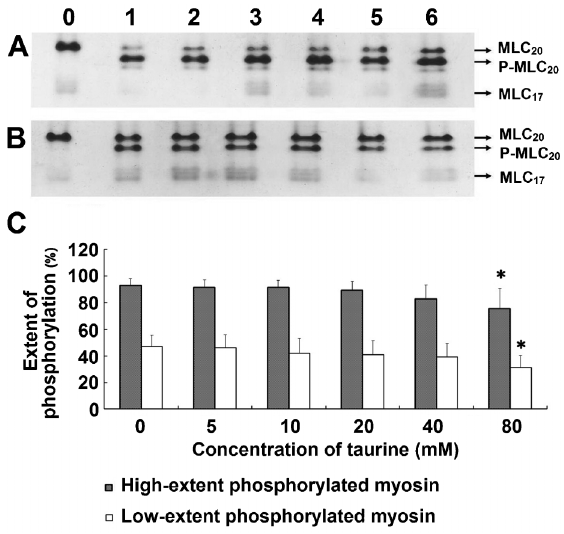
Figure 6. Effects of taurine on phosphorylated myosin. A , Effects of taurine on high-extent phosphorylated myosin, 0.02 m M myosin light chain kinase (MLCK), and 4.0 m M myosin purified from chicken gizzard smooth muscle used in the assay. B , Effects of taurine on low-extent phosphorylated myosin, 2.0 m M MLCK and 4.0 m M myosin purified from chicken gizzard smooth muscle used in the assay. Lanes 0-6 represent unphosphorylated myosin (without MLCK and taurine), high- or low-extent phosphorylated control (without taurine), high- or low-extent phosphorylated myosin with 5, 10, 20, 40, and 80 mM taurine, respectively. C , Extent of myosin phosphorylation, which was analyzed using the Gelpro software. The extent of phosphorylated myosin was calculated as percentage of phosphorylated regulatory myosin light chain of 20 kDa (MLC 20 ) in total MLC 20 . Mono-phosphoryla- tion was calculated as 100% phosphorylation. *P , 0.05 vs high- or low-extent phosphorylated control (without taurine) (one-way ANOVA) ( lane 1 ). MLC 20 : unphosphorylated MLC 20 (20 kDa regulatory myosin light chain); p-MLC 20 : mono-phosphorylated MLC 20 ; MLC 17 : 17 kDa myosin essential light